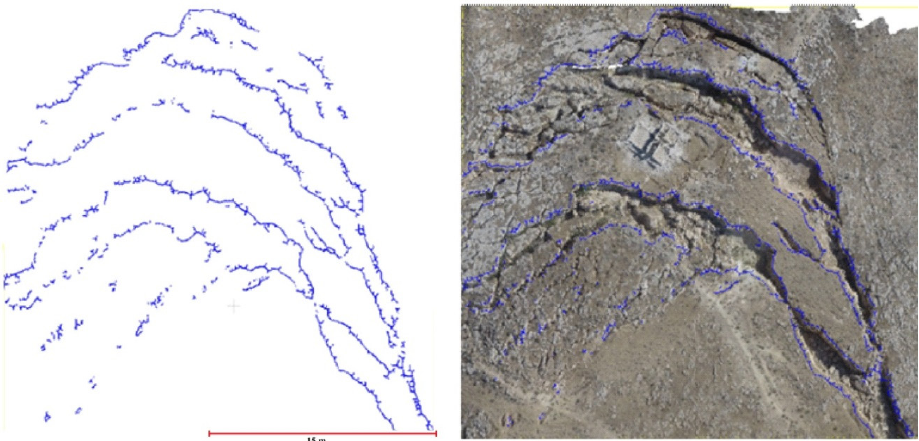
Figure 17. Final landslide scarp detection results (blue) based on Eigenvalues ratios of the topographic surface ( left image ) overlaid on the generated orthophoto using UAV images of the study area ( right image ).